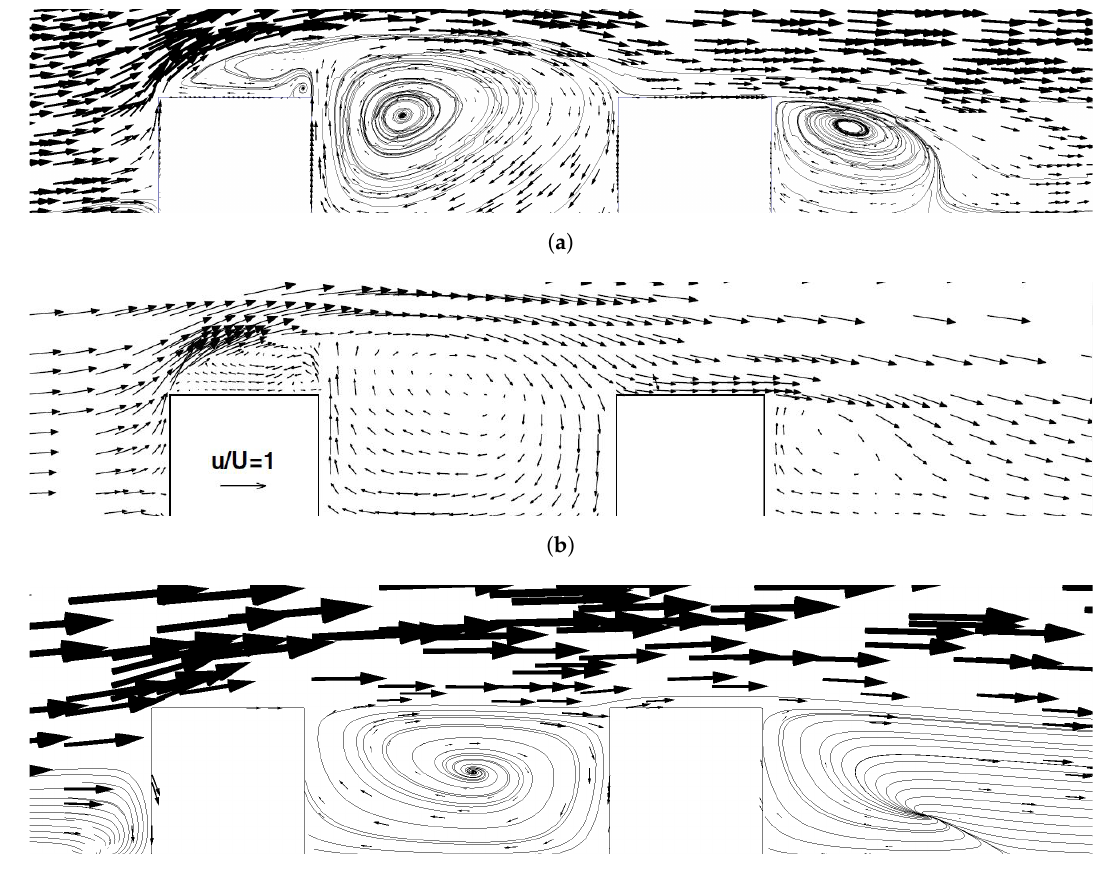
Figure 1. Comparison of the velocity fields of the simulations using the SST k − ω turbulence model ( a ) to experimental wind-tunnel data [15] ( b ). Simulations with the atmospheric inflow boundaries of the scaled-up geometry are shown in ( c ); these panels are not to scale. The size of the arrows has been adjusted to aid visualisation, and streamlines have been added to enhance the patterns in which the arrows are